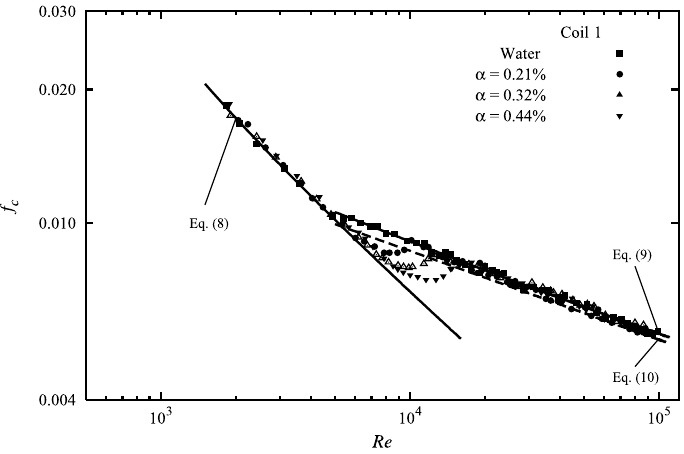
Fig. 8 E ff ect of air fraction on friction factor for helical pipe, δ = 0 .